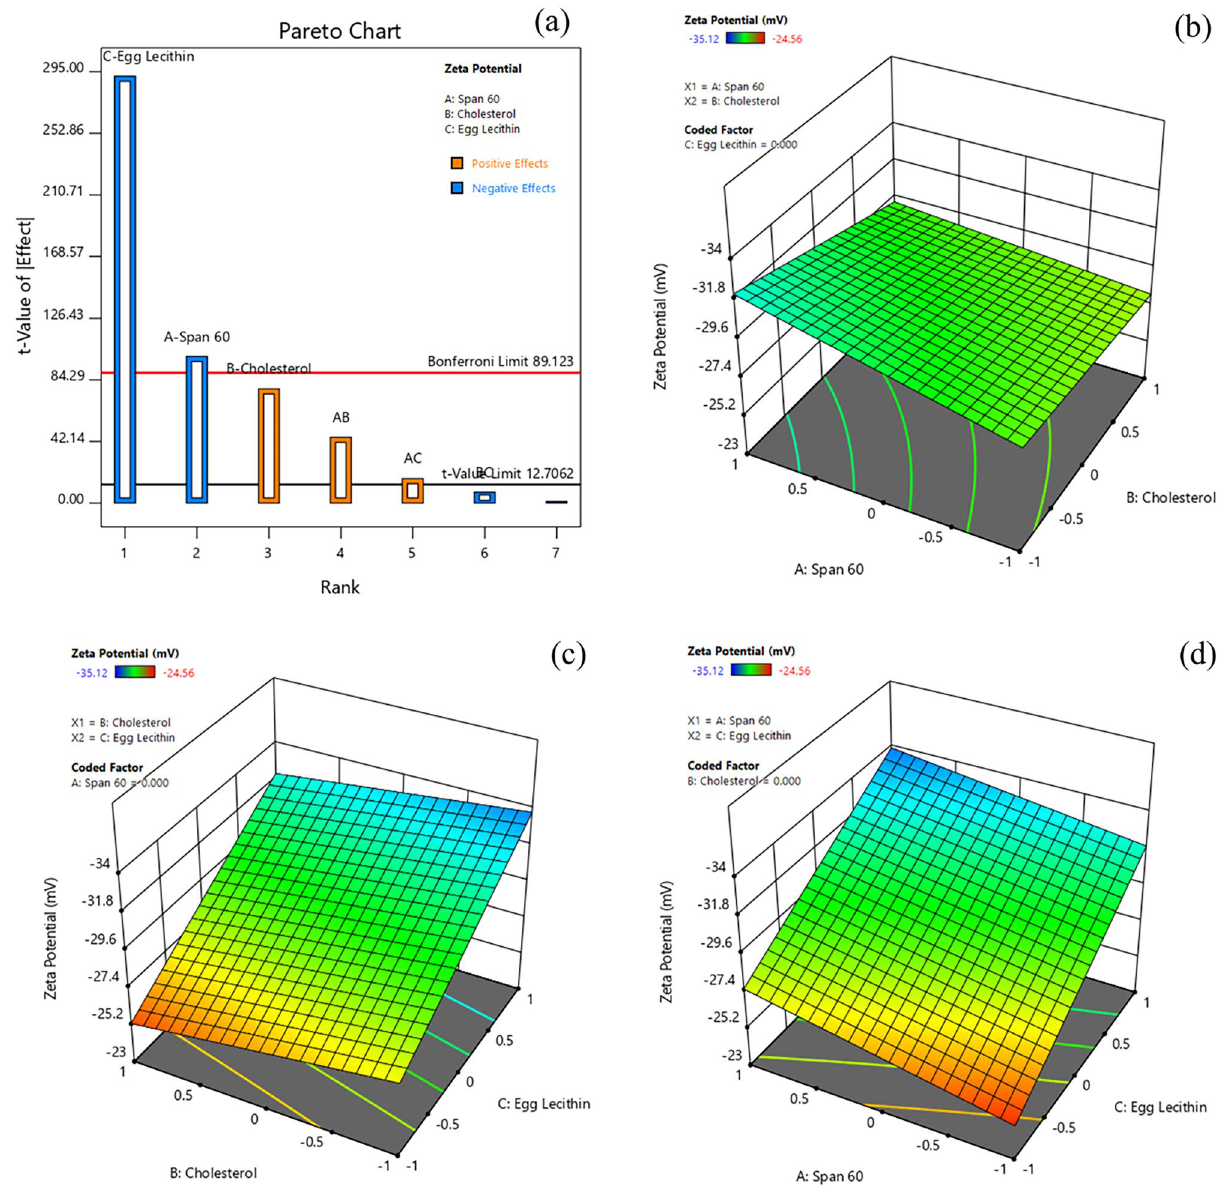
Figure 2. Effect of formulation variables ( a ) Pareto chart of zeta potential, ( b ) Span60*Cholesterol on zeta potential, ( c ) Cholesterol* Egg lecithin on zeta potential, ( d ) Span60*Egg Lecithin on zeta potential [Design- Expert version